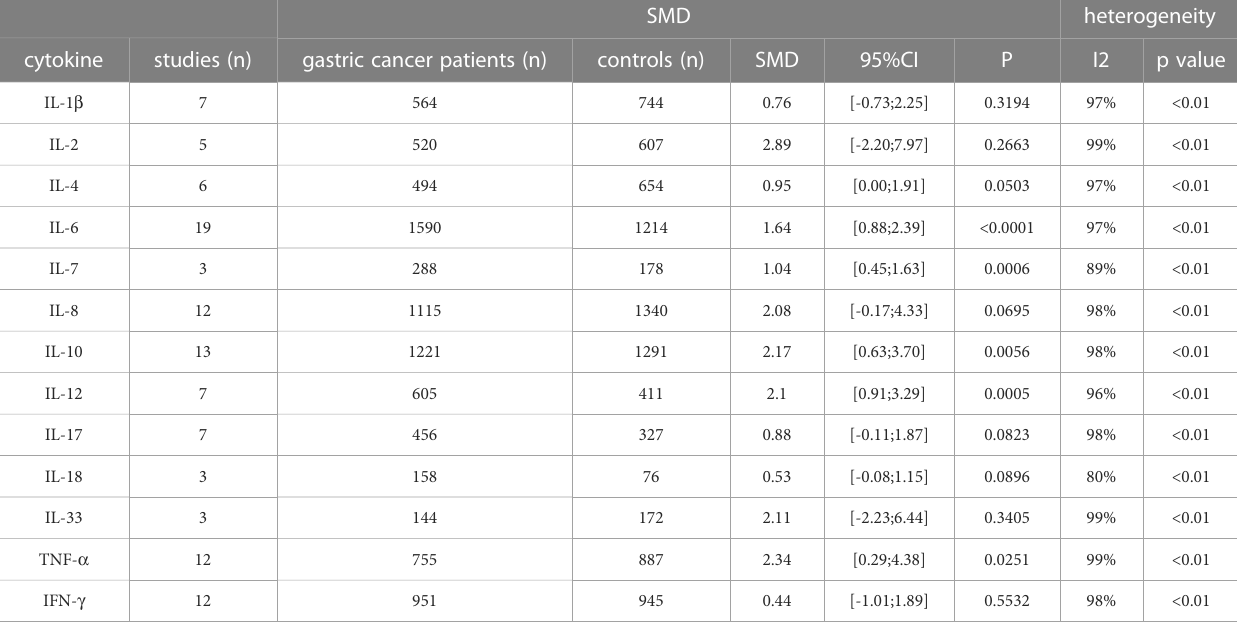
TABLE 3 Standardized mean difference of serum cytokine levels between gastric cancer cases and